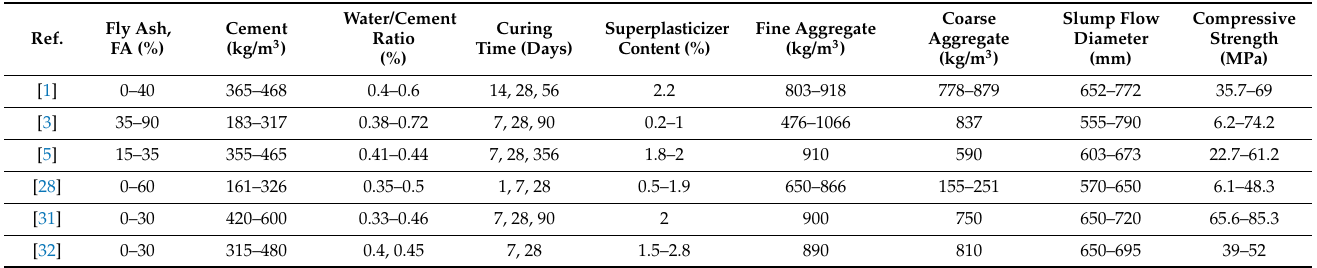
Table 1. Datasets used in the modeling